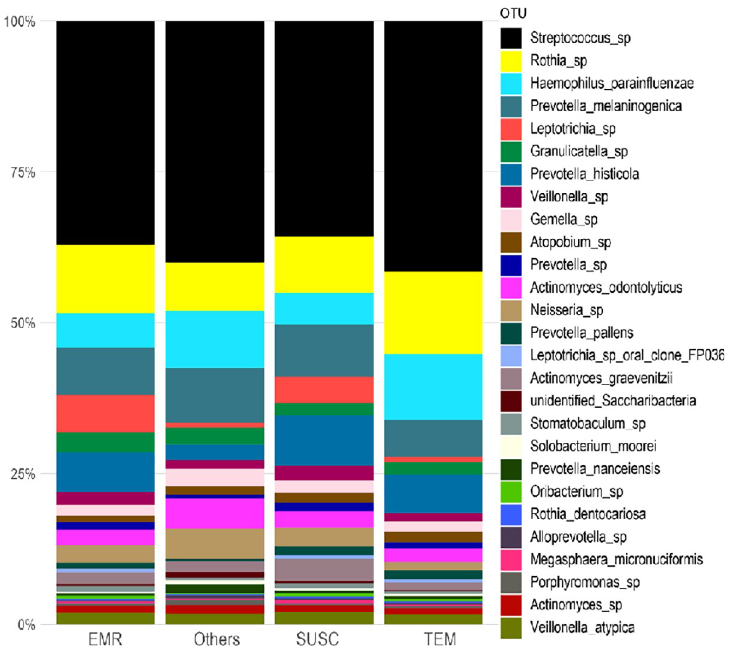
Fig 4. Relative proportion of oral bacteria stratified by resistance groups. Relative proportion refers to the percentage of each genus/species (indicated by different colors) in a resistance group. Overall, 22 samples were analyzed being 4 (18.2%) positive for the erm gene (EMR group), 6 (27.3%) for the bla TEM gene (TEM group), 2 (9.1%) for mec A and pbp 2 genes (Others group), and 10 (45.5%) negative for all searched genes (SUSC